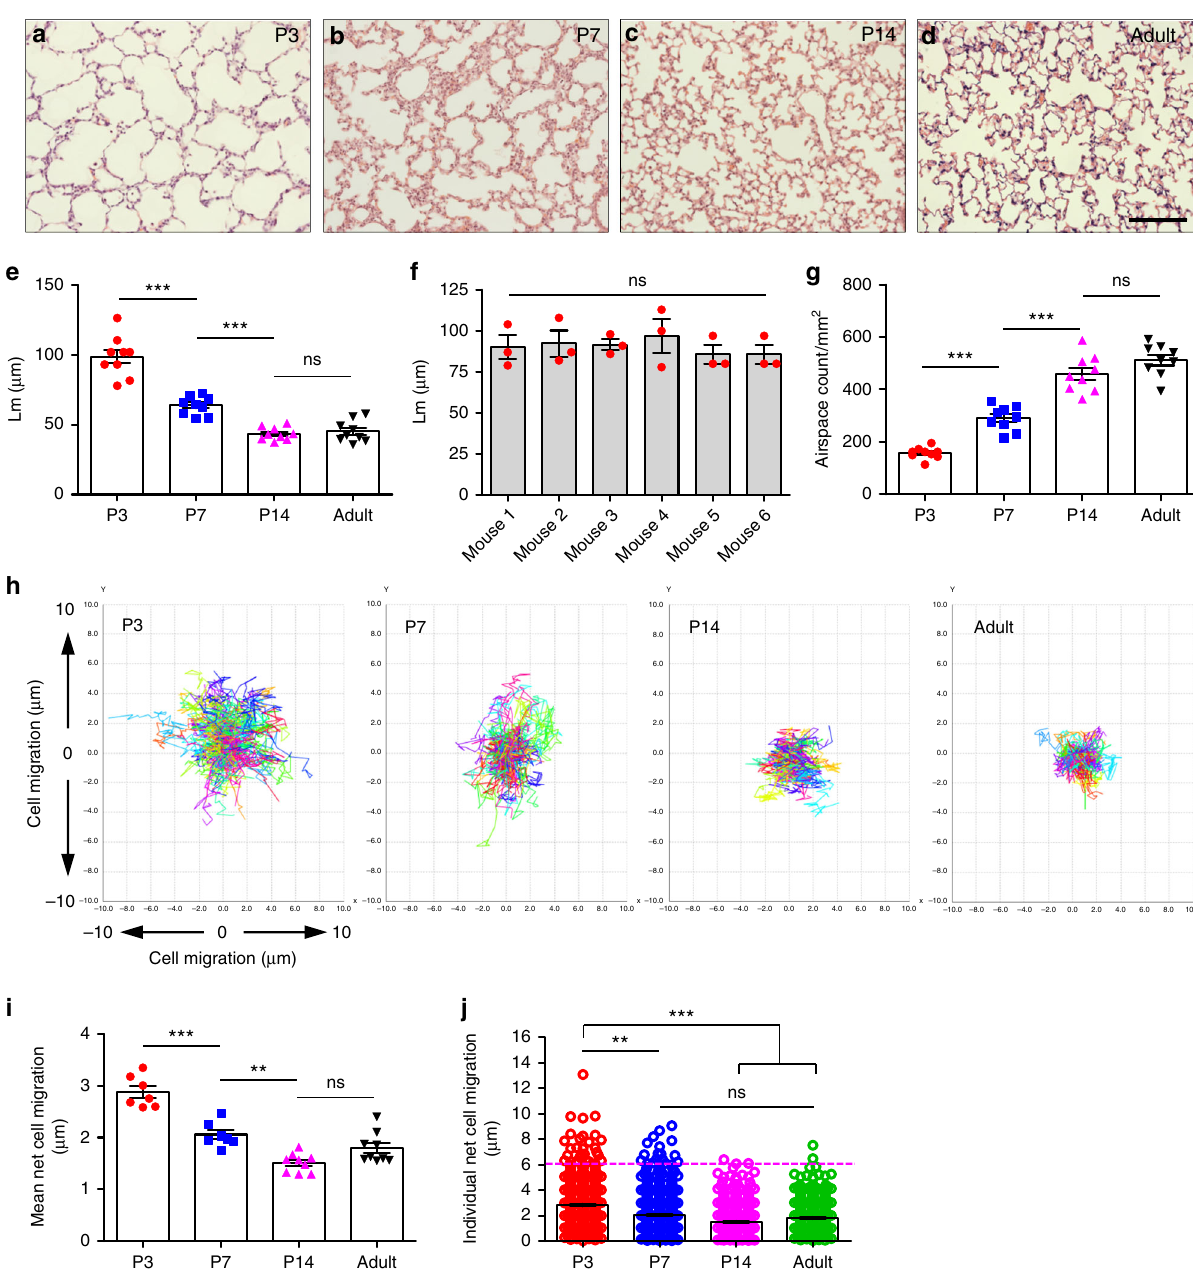
Fig. 2 Quanti fi cation of alveologenesis and alveolar epithelial cell migration in postnatal mice. H&E staining of left lung sections from P3, P7, P14 and adult mice ( a – d ); n = 3 mice from each age group. Scale bar = 100 µ m. Mean linear intercept (Lm) from P3, P7, P14 and adult mice ( e ); n = 3 separate mice from each age group, 3 H&E lung sections were quanti fi ed per mouse, *** p < 0.001; ns = not signi fi cant, one-way ANOVA with Tukey ’ s post hoc test. Mean linear intercept in PCLS from P3 mice ( f ), n = 6 separate mice, 3 H&E lung sections were quanti fi ed per mouse; ns = not signi fi cant, one-way ANOVA with Tukey ’ s post hoc test. Airspace count from P3, P7, P14 and adult lung sections ( g ); n = 3 separate mice from each age group, 3 H&E lung sections were quanti fi ed per mouse, *** p < 0.001; ns = not signi fi cant, one-way ANOVA with Tukey ’ s post hoc test. Individual cell tracking over 8 h in P3, P7, P14 and adult PCLS, 70 – 160 cells were tracked per fi eld ( h ). Mean net epithelial cell migration over 8 h in P3, P7, P14 and adult lungs ( i ); ** p < 0.01, *** p < 0.001; ns = not signi fi cant, one-way ANOVA with Tukey ’ s post hoc test, n = 3 mice for each age group, 2 – 3 fi elds were quanti fi ed from one slice per mouse, per experiment. Individual net cell migration in P3, P7, P14 and adult lungs over 8 h (each dot represents a single cell). P3, 607 cells, P7, 944 cells, P12, 950 cells and adult, 613 cells were tracked ( j ), n = 3 mice from each age group, 2 – 3 fi elds were quanti fi ed from one slice per mouse, per experiment, ** p <